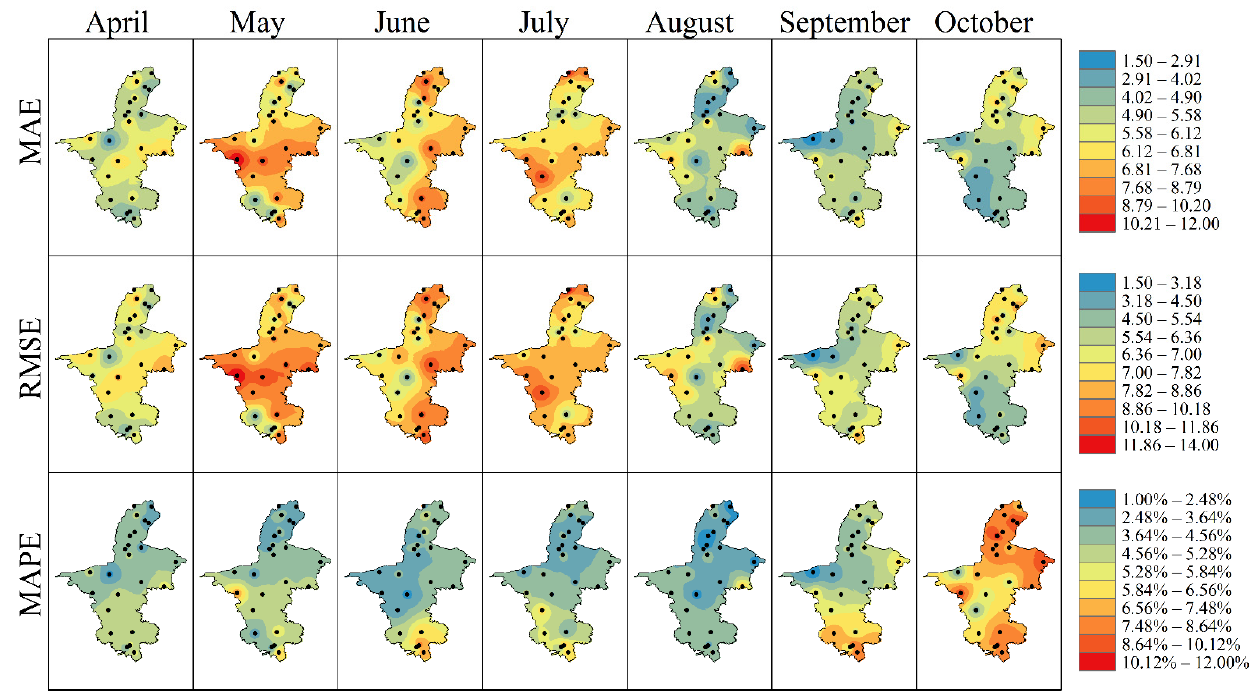
Figure 10. Error analysis of fitted values: mean absolute error (MAE), root mean squared error (RMSE), and mean absolute percentage error (MAPE) .